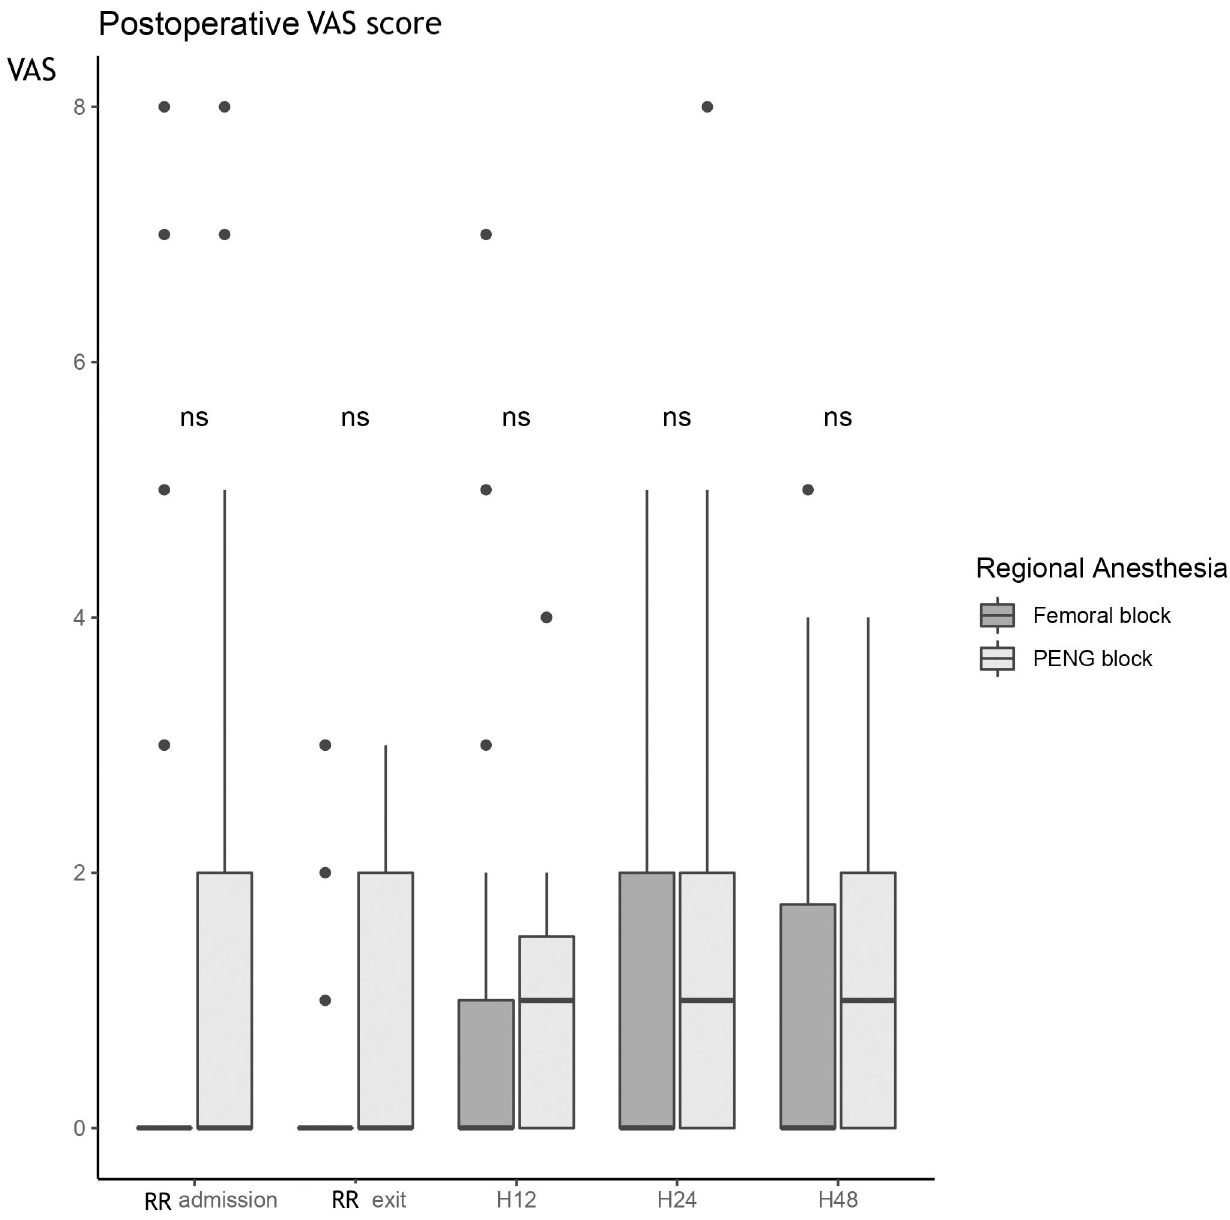
Fig 4. Postoperative VAS score at different times: Arriving in RR, before leaving the RR, 12 hours postoperatively (H12), 24 hours postoperatively (H24) and 48 hours postoperatively (H48). Explanation of the figure: Box-plot diagram: The rectangle extends from the first quartile to the third quartile and is intersected by the median. The segments at the ends of the rectangle provide information on the extreme